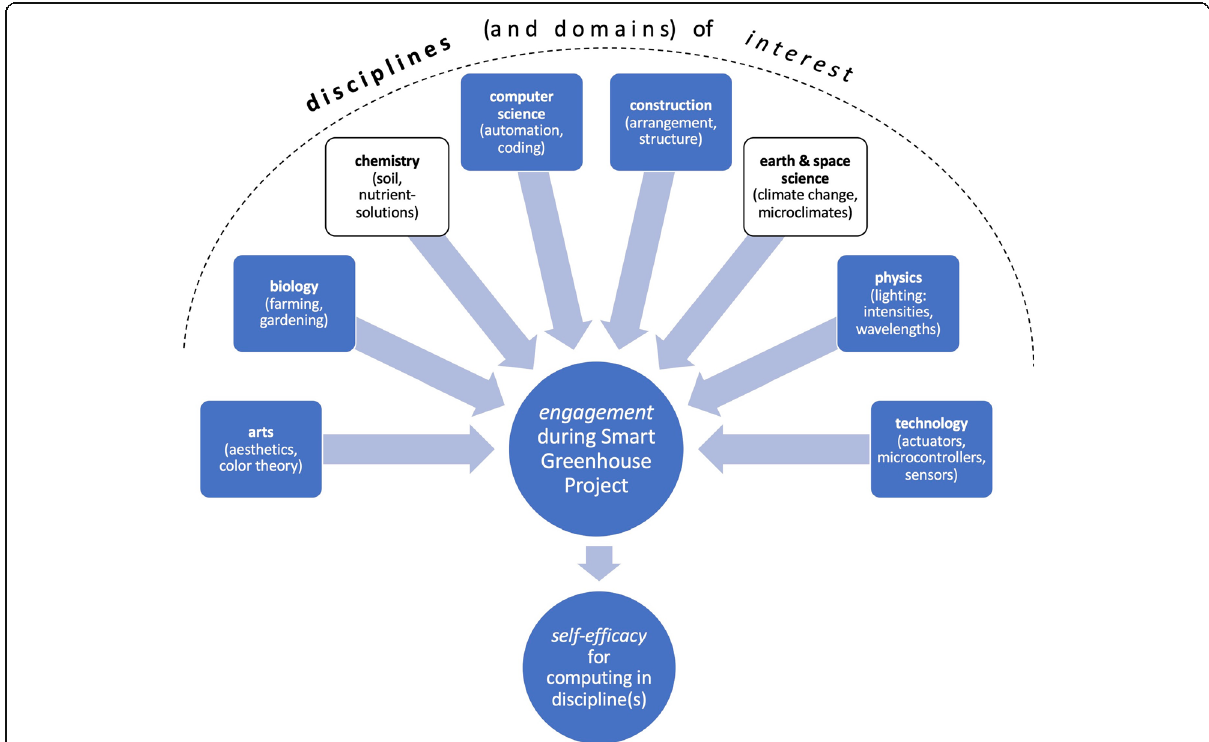
Fig. 2 Our conceptual framework for studying adolescents ’ practices of computing, engineering, and science. At least six disciplines were pluralistically represented in the project, with two more disciplines (chemistry and earth & space science) emphasized in other implementations (Asante et al., 2021). In general, pre-existing interest in one or more discipline(s) supports engagement in the project, which in turn promotes self-efficacy for computing in